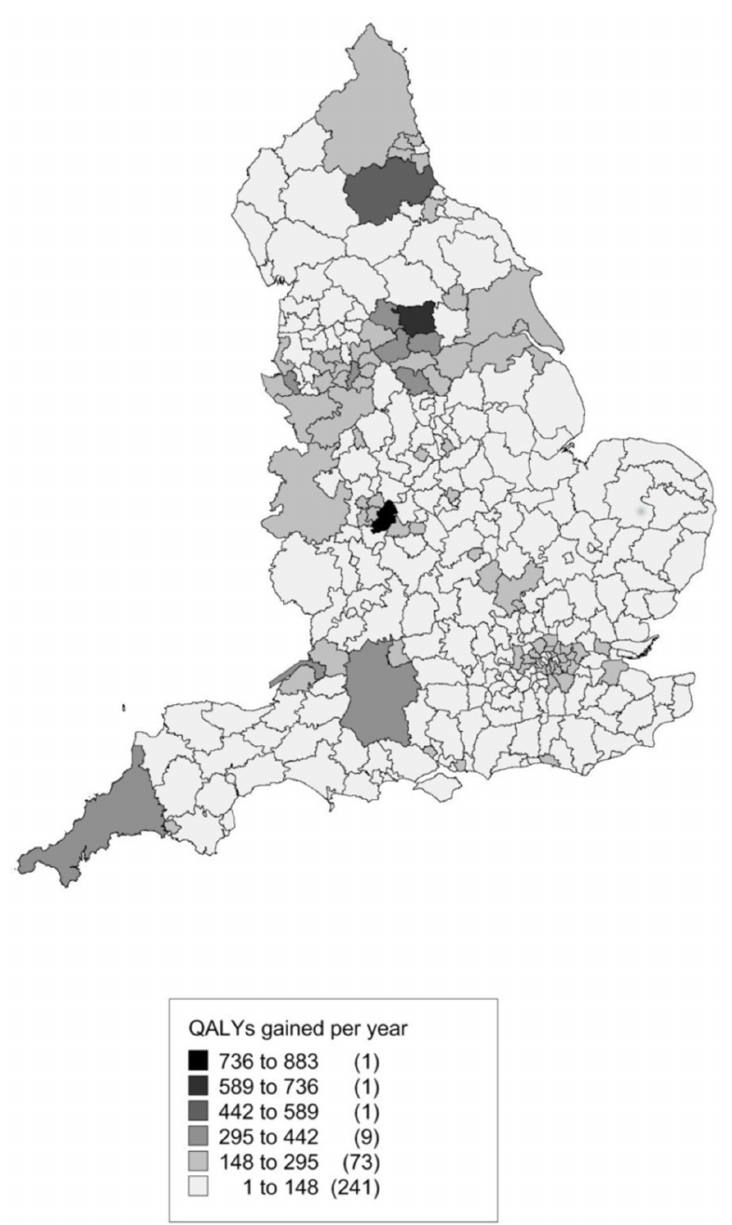
Fig 5. Thematic map showing estimated QALYs gained per year by local authority as a result of a 20% SSB duty.